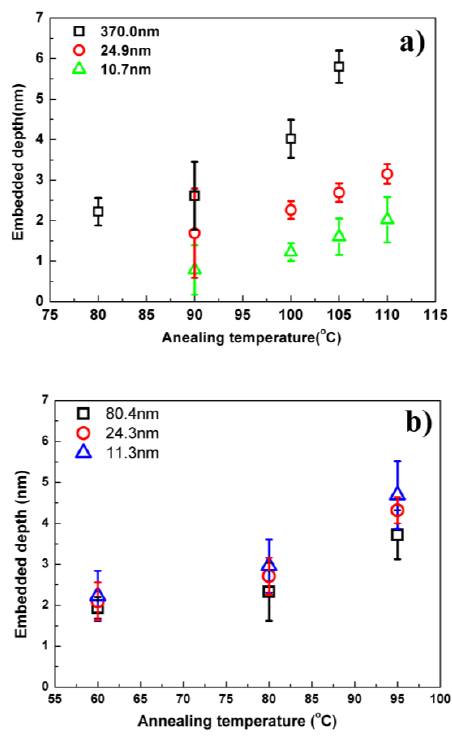
Figure 6. Embedding depth of gold nanoparticle versus annealing temperature on ( a ) PMMA and ( b ) PS thin film with different thicknesses on silicon substrate.